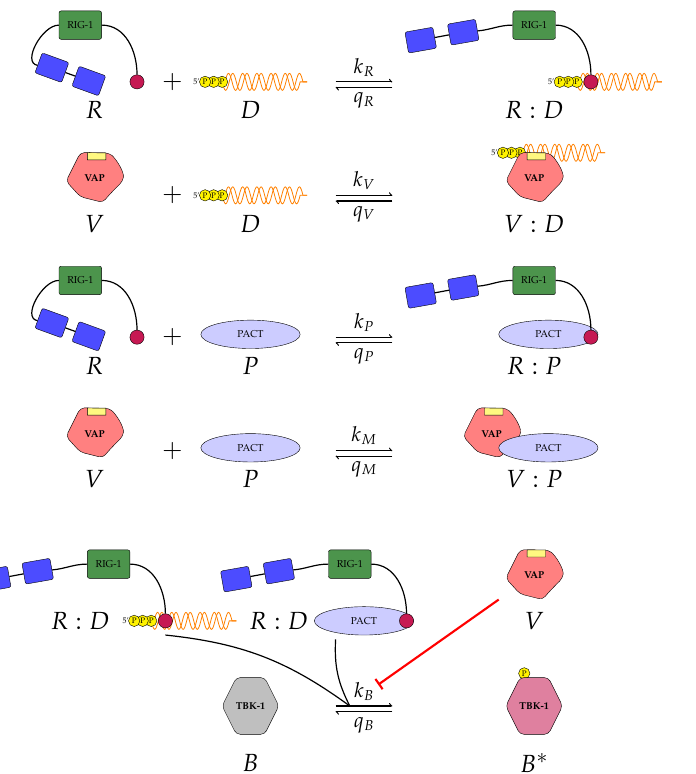
Figure 2. A second model of type I IFN inhibition by viral protein (model 2). Model 2 includes the role of protein activator of the interferon-induced protein kinase (PACT) molecules, since PACT has been identified as a secondary activator of RIG-I during viral infections [23,28]. In this model there are ten reactions and five molecular complexes. Free VAP inhibits phosphorylation of TBK1, as indicated by the flat head red